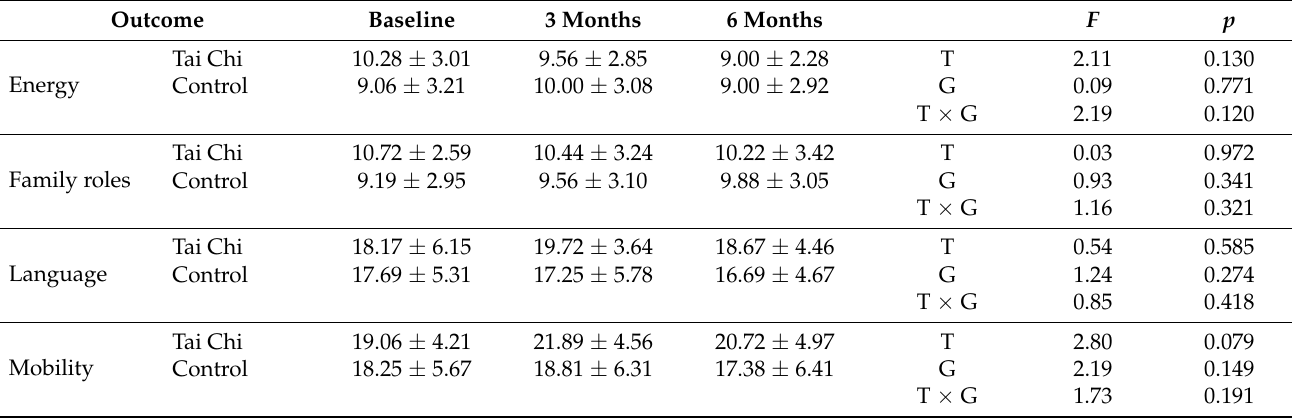
Table 5. Effects of the Tai Chi-based stroke rehabilitation program on Stroke-specific Qaulity of Life (SS-QOL) ( N = 34).